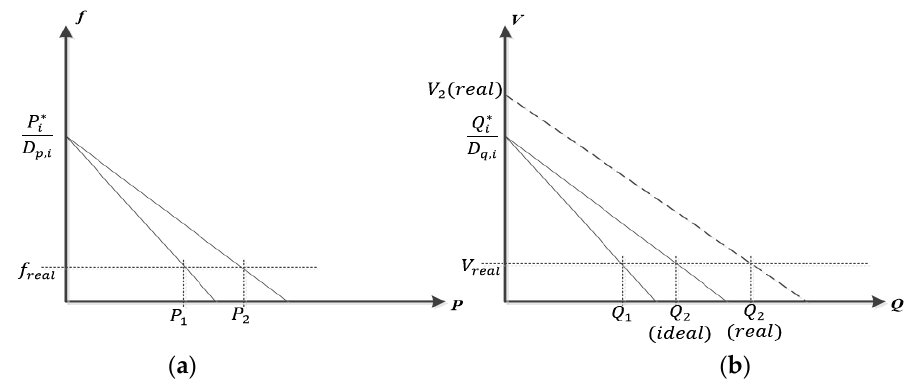
Figure 2. ( a ) A typical P-f curve; and ( b ) a tdypical Q-V droop curve.